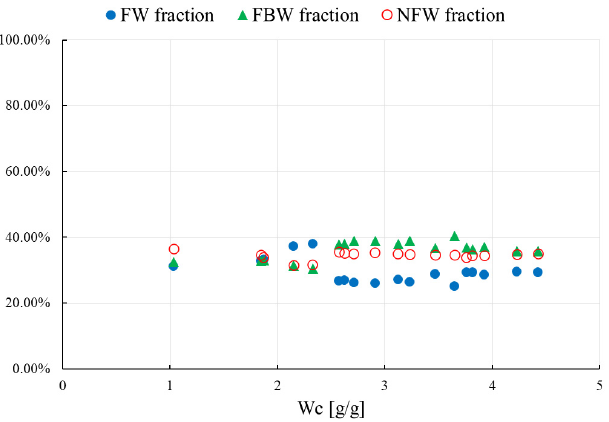
Figure 10. Raw HPC: percentage of fractions of water in the mixture as a function of water concen- tration W c . The blue circles indicate the FW fraction, the green triangles the FBW fraction, the red empty circles the NFW fraction.